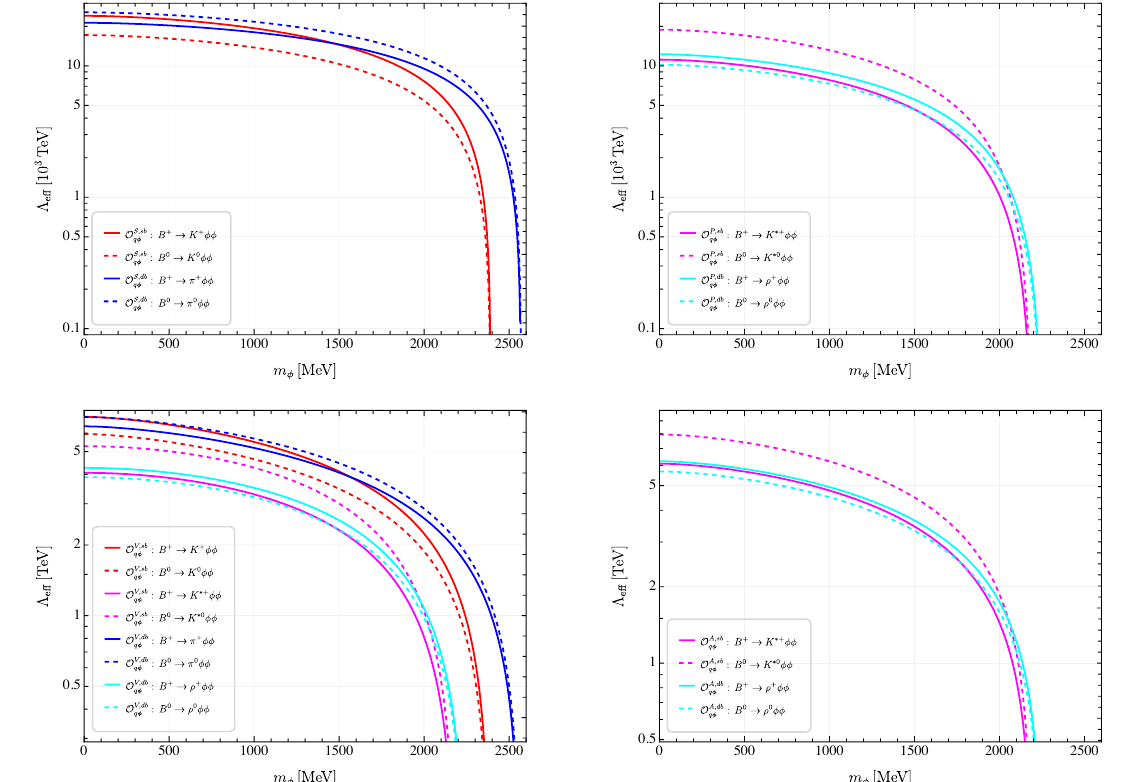
Figure 2 . Constraints on the effective new physics scale for each operator involving a b quark as a function of the DM mass m from all possible relevant B meson decay